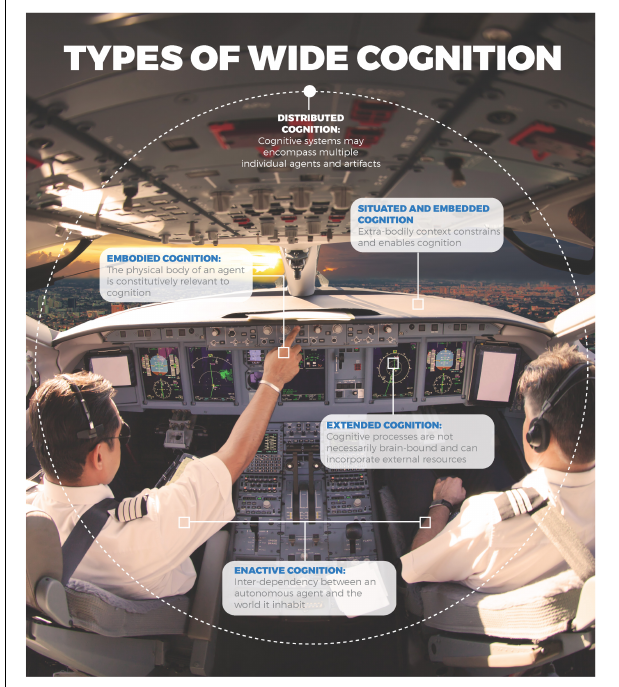
FIGURE 1 | Wide approaches to the study of